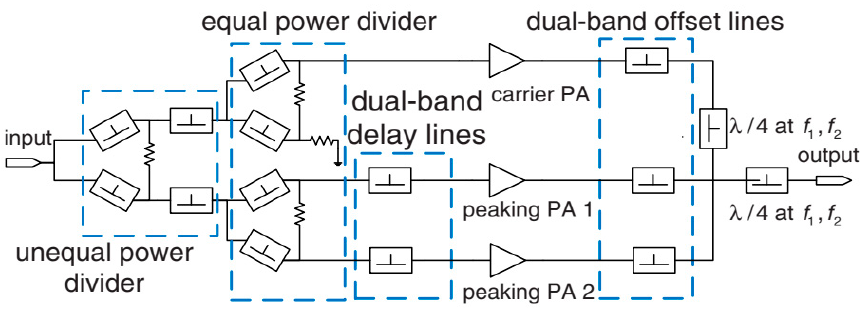
Figure 12. Tri-way Dual-band DPA with frequency dependent power division [43].